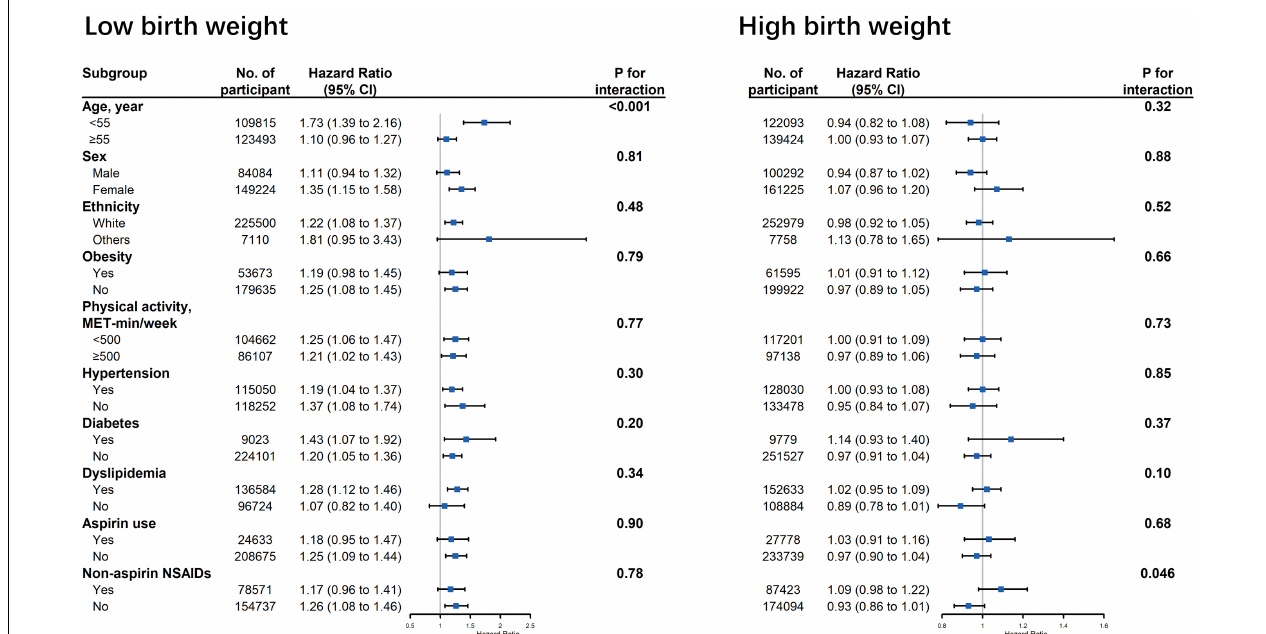
FIGURE 2 | Association between birth weight and risk of cardiovascular disease stratified by potential effect modifications. CI, confidence interval; NSAID, non-steroidal anti-inflammatory drug. Results were adjusted for age, sex, ethnicity, Townsend Deprivation Index, education, BMI, physical activity, smoking status, alcohol consumption, vegetable and fruit consumptions, maternal smoking, breastfed as a baby, part of multiple birth, aspirin use, non-aspirin NSAID use, vitamin, mineral and other dietary supplement use, hypertension, diabetes, dyslipidemia.